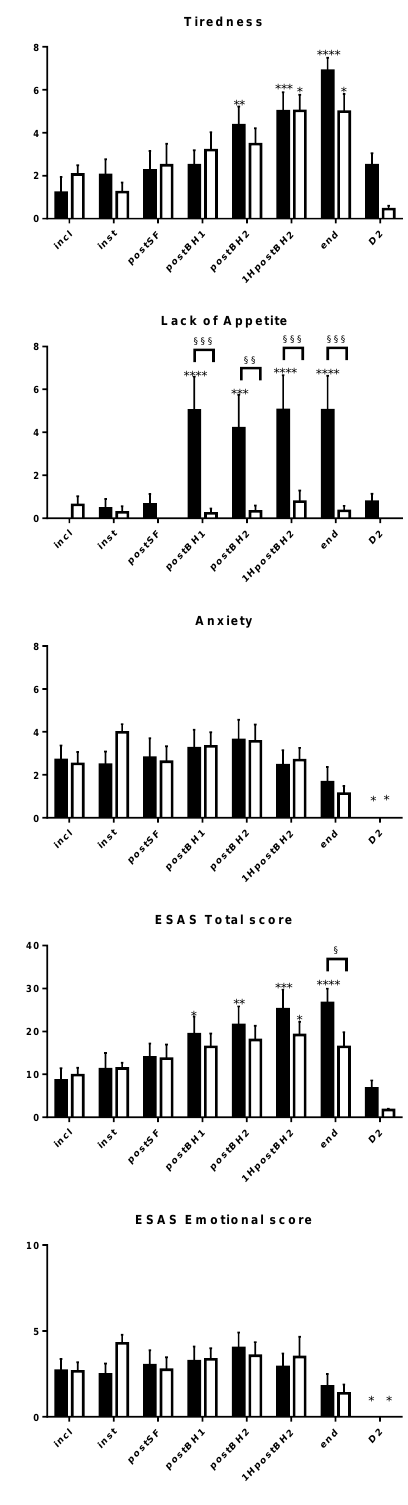
Figure 3. Time course of the ESAS variables. Only variables for which a significant time or group interaction was found (repeated-measures ANOVA, p < 0.05) are reported. In black: control group. In white: electroacupucture group. Post hoc tests for score change compared to incl score: *, p < 0.05; **, p < 0.01; ***, p < 0.001; ****, p < 0.0001. Post hoc tests for score difference between the control and EA groups at a given timepoint: §, p < 0.05; §§, p < 0.01; §§§, p < 0.001. incl, inst, postSF, postBH1, postBH2, 1HpostBH2, end, D2: various timepoints before, during, or after the surgery (see text). Significant group interaction (F (1, 8) = 10.06, η 2 = 0.14, p = 0.013) and time × group interaction (F (7, 56) = 5.09, η 2 = 0.12, p = 0.0002) were observed for the item “ lack of